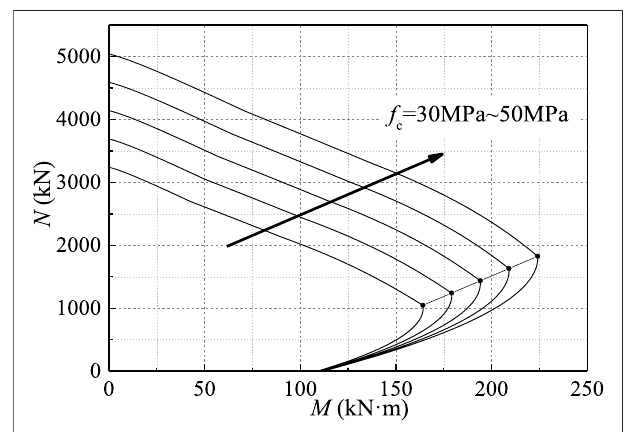
FIGURE 8 | N-M interaction curves with different ECC compressive strengths.